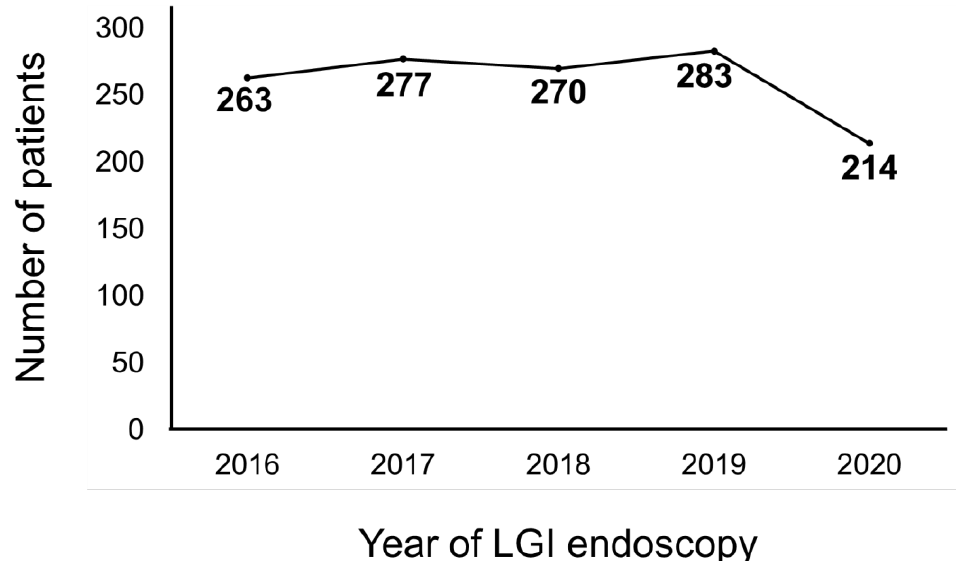
Figure 1. Number of patients that had received a lower gastrointestinal (LGI) endoscopy from 2016 to 2020.